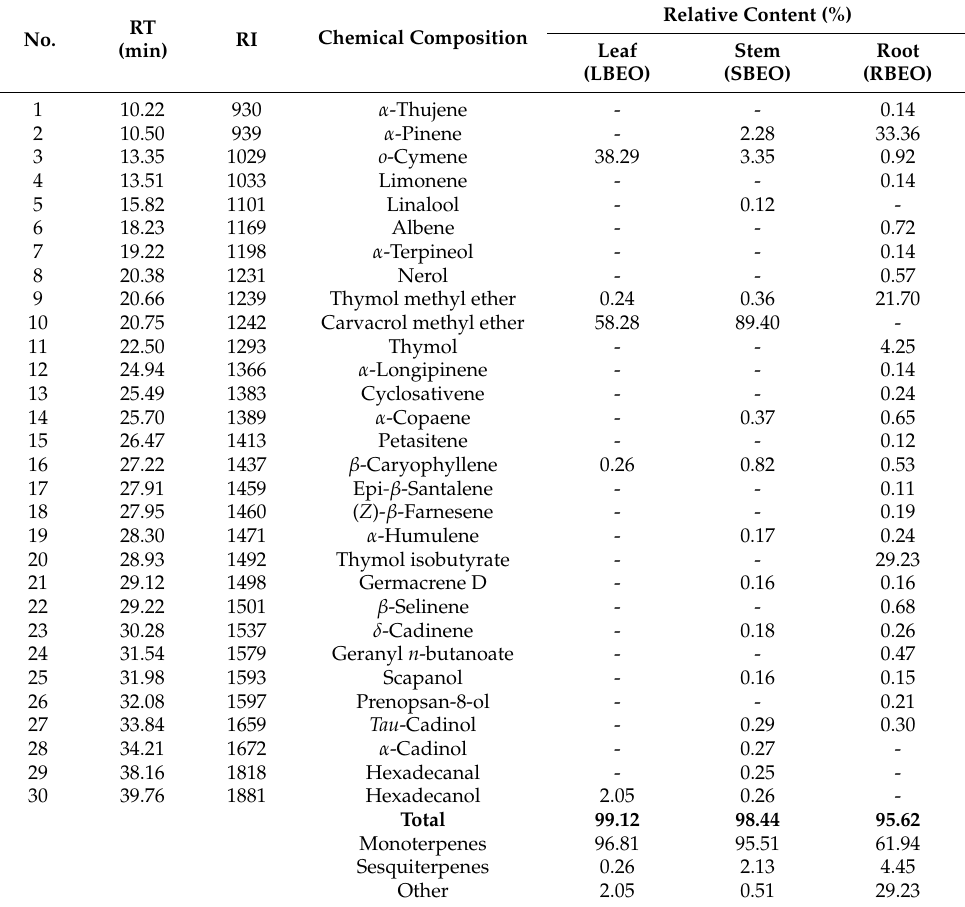
Table 1. Chemical compositions of the BEOs from the leaves, stem, and roots analyzed using GC- MS/GC-flame ionization detection